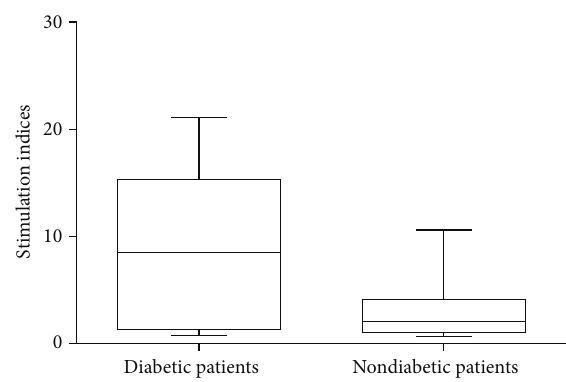
Figure 2: Proliferative response of peripheral blood mononuclear cell samples obtained from the 17 patients with carotid atheroscle- rosis divided according to the presence/absence of type 2 diabetes. ∗ 𝑃 = 0.04